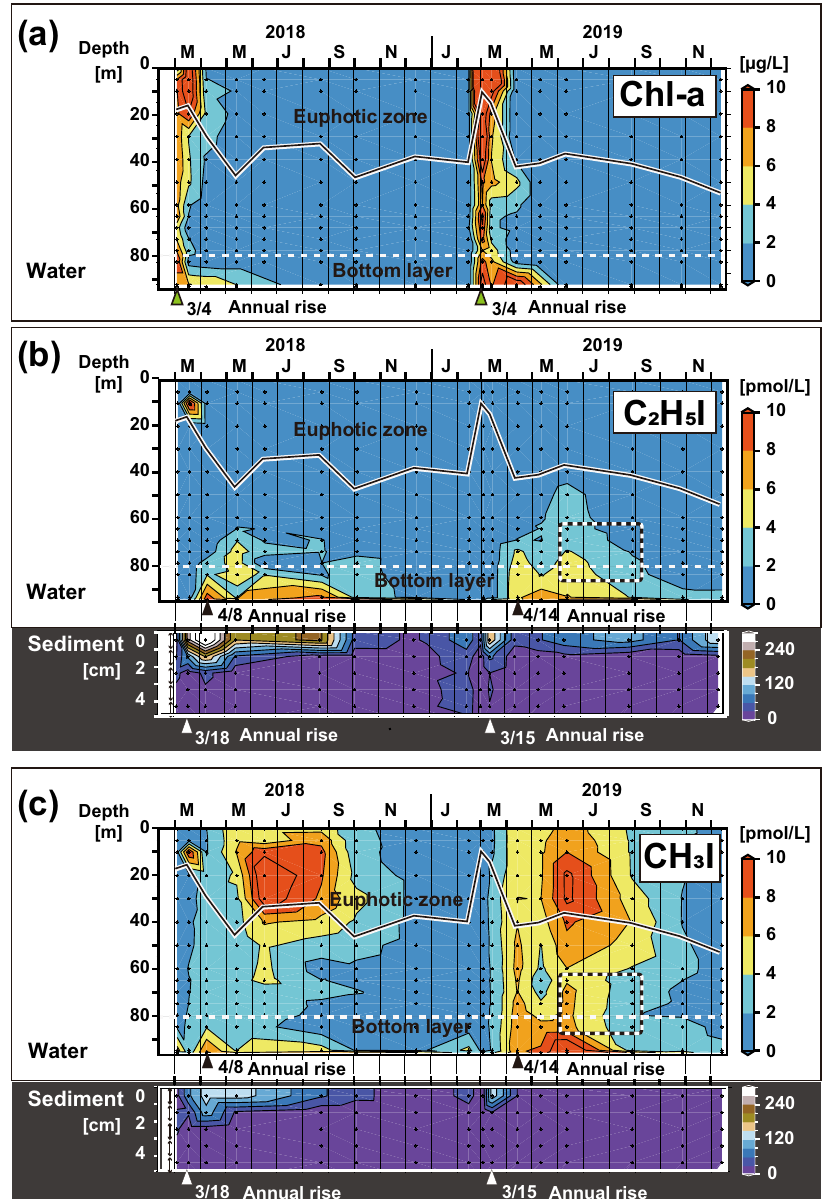
Fig. 2 Time sections of vertical pro fi les in water column and sediment. a Chl-a in water column. b C 2 H 5 I in water column and sediment. c CH 3 I in water column and sediment. The dates of annual rises in concentration are marked with triangles below each panel. Solid black lines indicate the euphotic zone depth, at which photosynthetically active radiation (PAR) is 1% of the surface PAR. White dotted lines separate bottom water below 80 m depth. Squares outlined with black-and-white dotted lines indicate the temporal-vertical range where C 2 H 5 I and CH 3 I concentrations decreased with